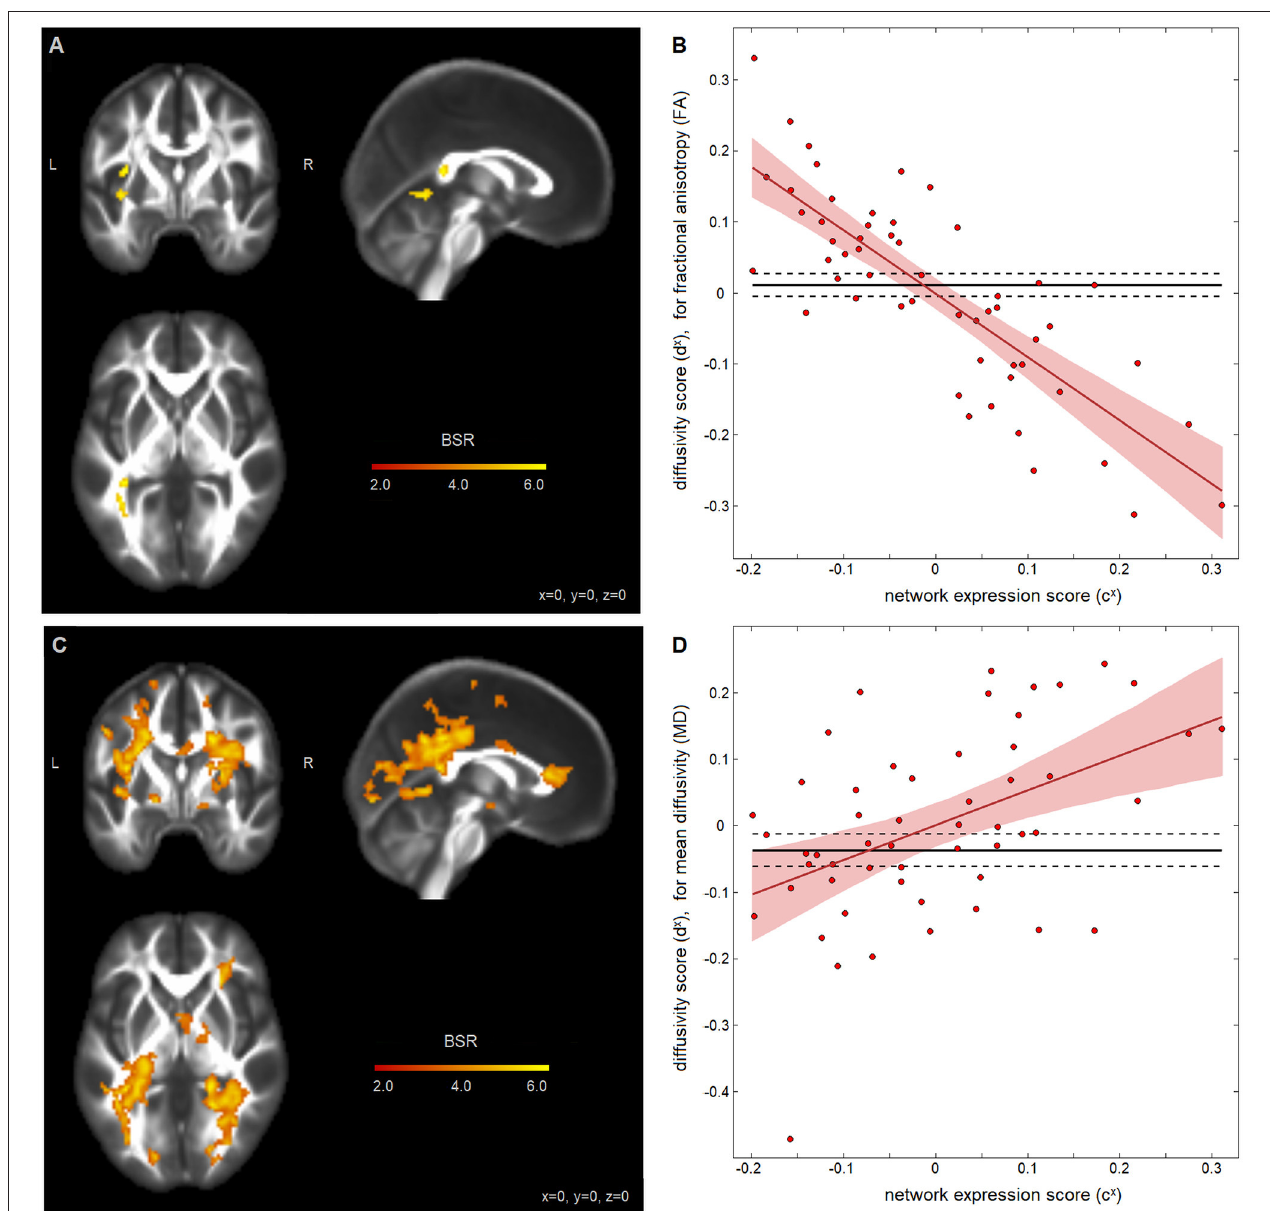
FIGURE 3 | Diffusion-weighted measures and insular network expression scores among concussed athletes. Brain maps show significant effect of fractional anisotropy (FA) in (A) and mean diffusivity (MD) in (C) , depicted as maximum intensity projections in orthogonal planes [Montreal Neurological Institute (MNI) coordinates: x = 0, y = 0, z = 0]. Scatter plots show the diffusivity scores for (B) FA data and (D) MD data, plotted against network expression scores for the concussed group, along with the regression line of best fit (solid red line) and its 95%CI (shaded area). The control mean is also plotted (solid black line) with 95%CIs of the mean (dashed